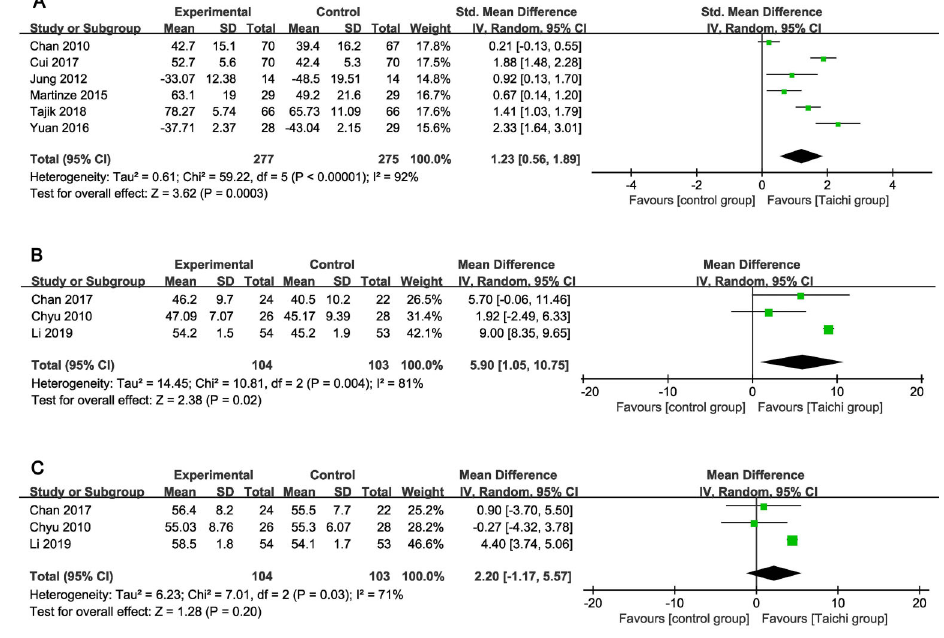
Figure 2. Forest plot of the effectiveness of Tai chi exercise on quality of life in older adults. See Table 1 for reference